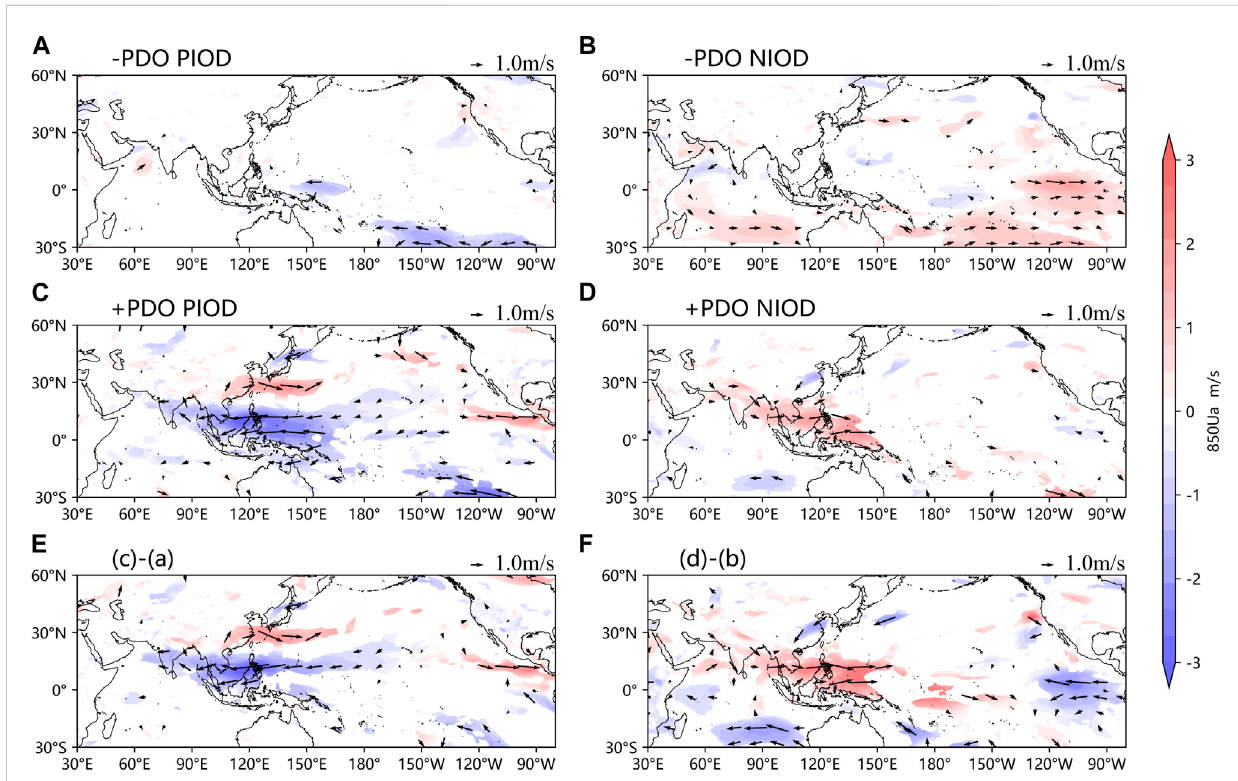
FIGURE 11 (A,B) Under the PDO cold phase, (C,D) PDO warm phase (A,C) positive IOD, (B,D) negative IOD 850 hPa wind anomaly in the following summer (vector; Unit: m/s); PDO cold and warm phase (E) positive IOD (F) negative IOD 850 hPa wind anomaly difference in the following summer (vector; Unit: m/s); Colour shade indicates latitudinal wind